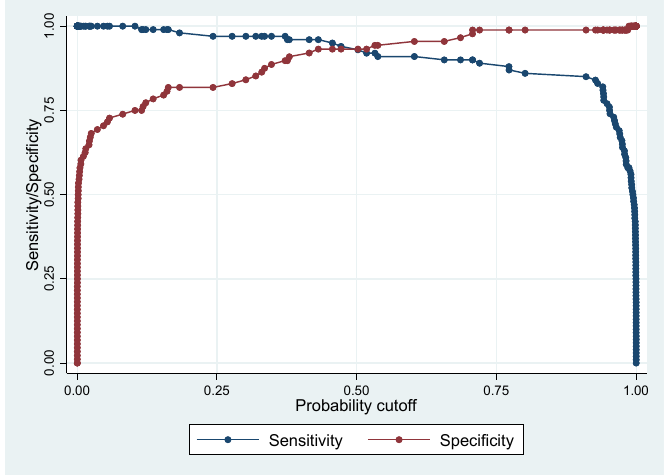
Figure 2. The evolution of sensitivity and specificity for different cutoffs with an optimal cutoff value of about 0.5. Table 2. Performance of the multivariate model to classify patients as disseminated histoplasmosis or